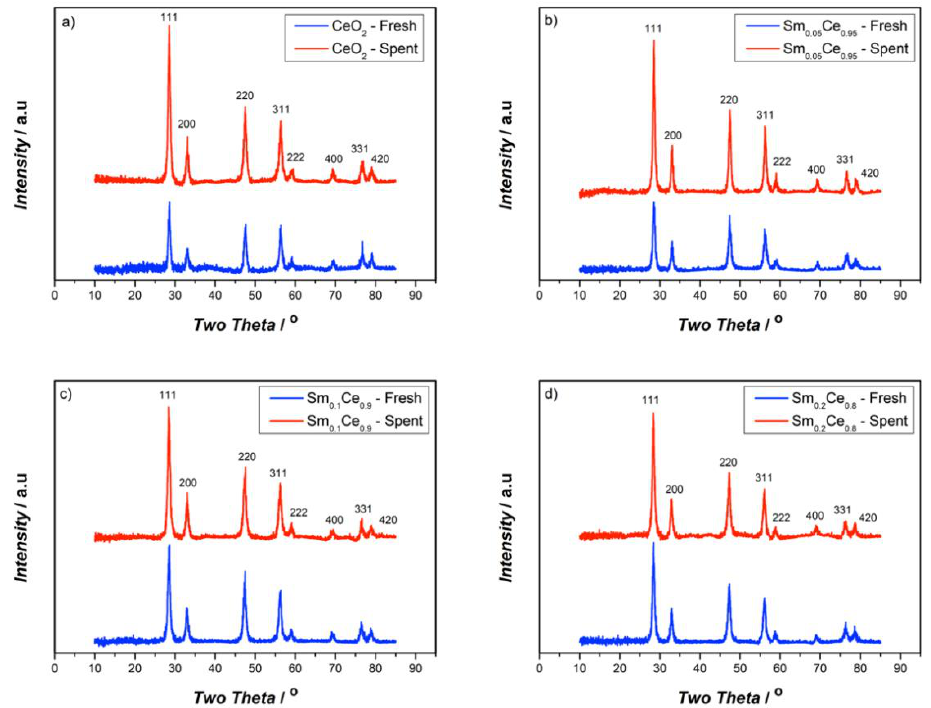
Figure 1. XRD results of fresh and spent catalysts after five cycles of reactions: ( a ) CeO 2 , ( b ) Sm 0.05 Ce 0.95 , ( c ) Sm 0.1 Ce 0.9 , ( d ) Sm 0.2 Ce 0.8. Table 1. Texture results of Sm-doped ceria fresh and spent catalysts (after five cycles). Percentages for spent catalysts indicate relative changes compared to fresh catalysts.